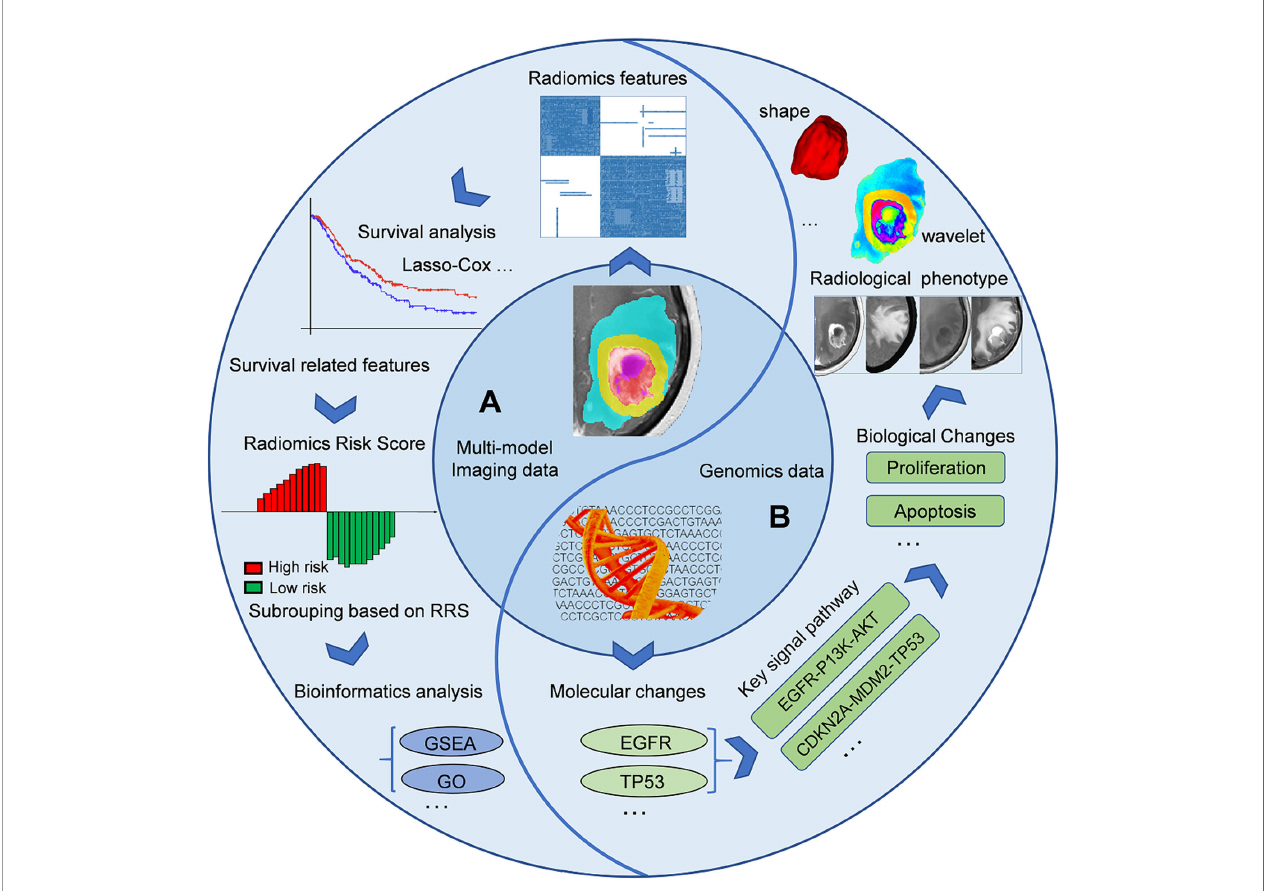
FIGURE 2 | General work fl ow of imaging-genomics studies. A imaging-genomics research can generally build the relationship between imaging phenotypes and genetic characteristics from two perspectives. (A) , Left semicircle, from imaging phenotypes to genomic characteristics: using features extracted from the sub-areas of tumors in multi-modal images to construct individualized RRS or divide patients into different subgroups, and utilize the corresponding sequencing data for further bioinformatics analysis (such as GO or GSEA). (B) , Right semicircle, from genomic characteristics to imaging phenotypes: bioinformatics analysis can reveal the pathways, biological processes, and expression of protein corresponding to speci fi c molecular markers detected by sequencing technique. These biological processes can fi nally be mapped in the form of different imaging phenotypes (like necrosis or edema) on multi-modal images, and then captured by the quantitative radiomic features (such as shape, texture, or wavelet features). EGFR, Epidermal growth factor receptor; GO, Gene Ontology; GSEA, Gene set enrichment analysis; RRS, Radiomic risk